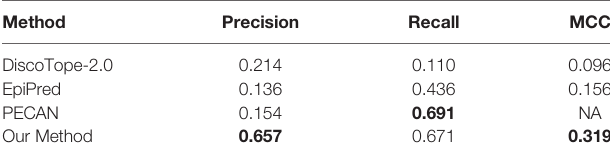
TABLE 2 | Performances of BCEs prediction methods.